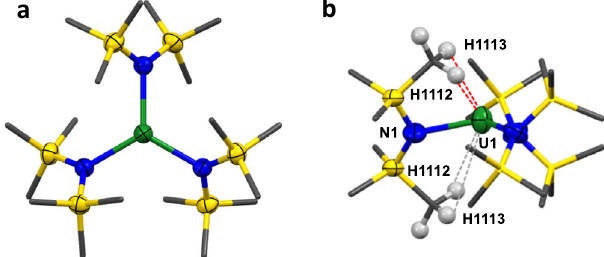
Fig. 3 High pressure structure of UN3. a Solid state structure of UN3 from top at 4.09 GPa, b side view of the solid-state structure of UN3 showing pyramidalization and U-CH agostic interactions at 4.09 GPa (red = close contacts, grey = longer contacts). UN3 = U(N(SiMe 3 ) 2 ) 3 . Atom colour code: Green = U; blue = N; gold = Si; grey = C. not change signi fi cantly with pressure (from 2.289(3) Å at